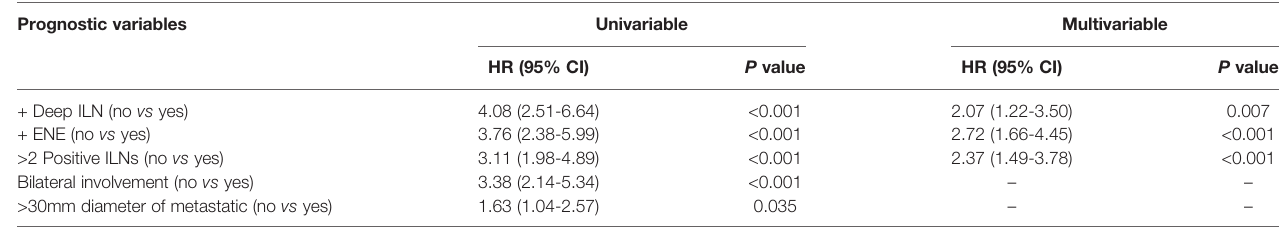
>30mm diameter of metastatic (no vs